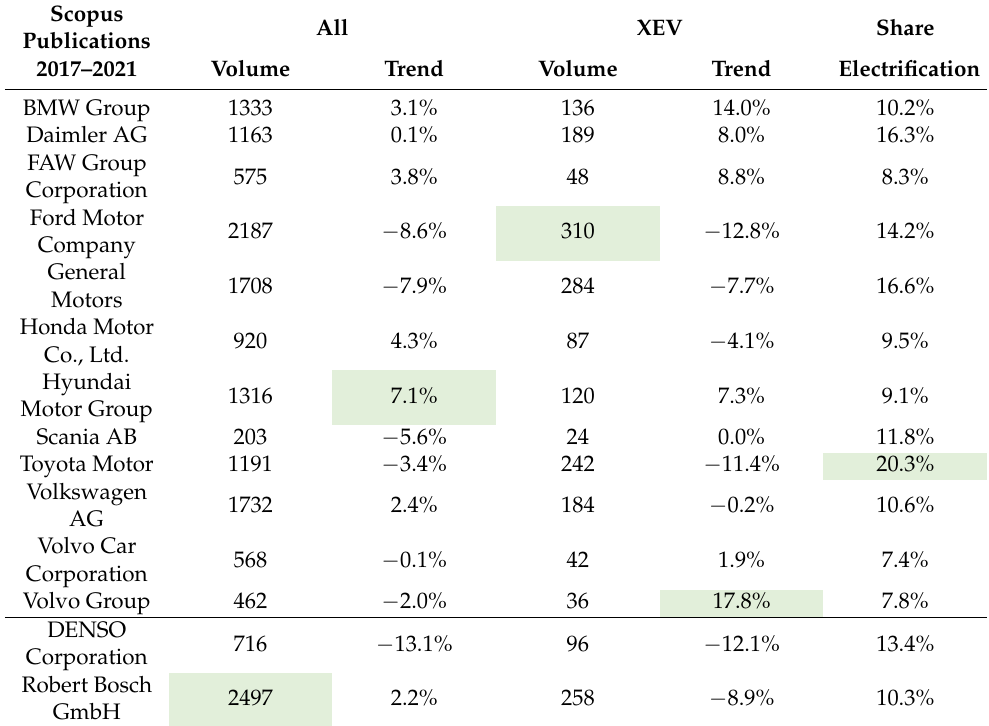
Table 6. Electrification publications with corporate (co-)authors.